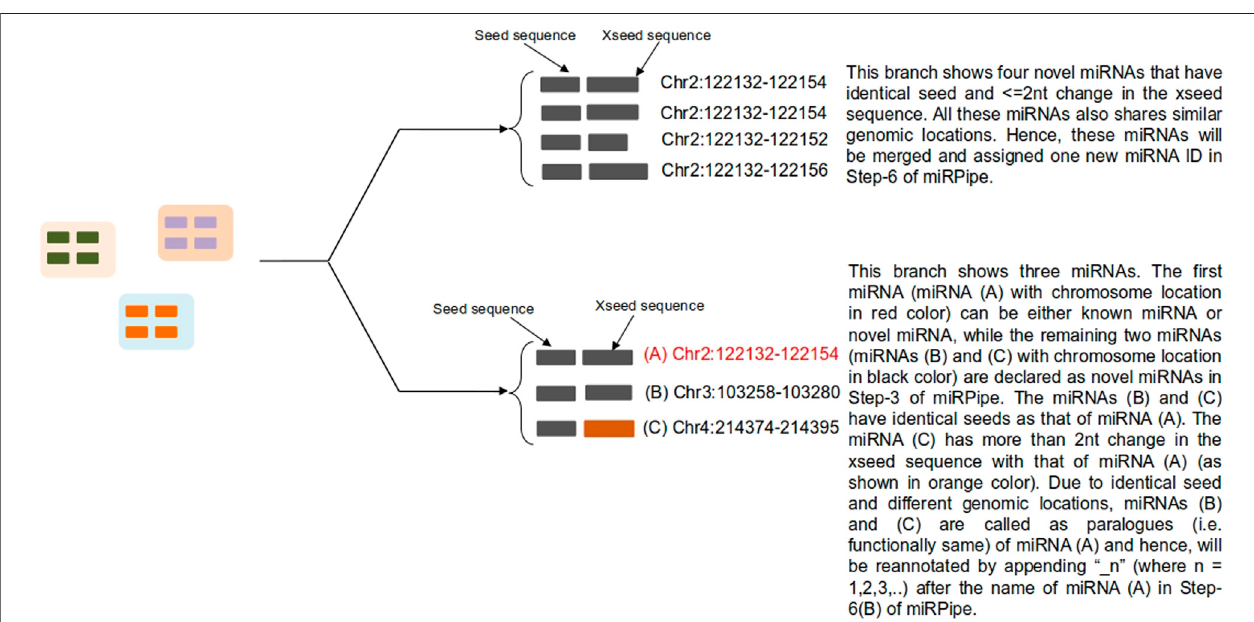
FIGURE 3 | Functional annotation of novel miRNAs using seed-based clustering. Above fi gure shows an example for all possible scenarios for cluster formation of novel miRNAs functional annotation with known and novel miRNAs along with their genomic location of sequence alignment.